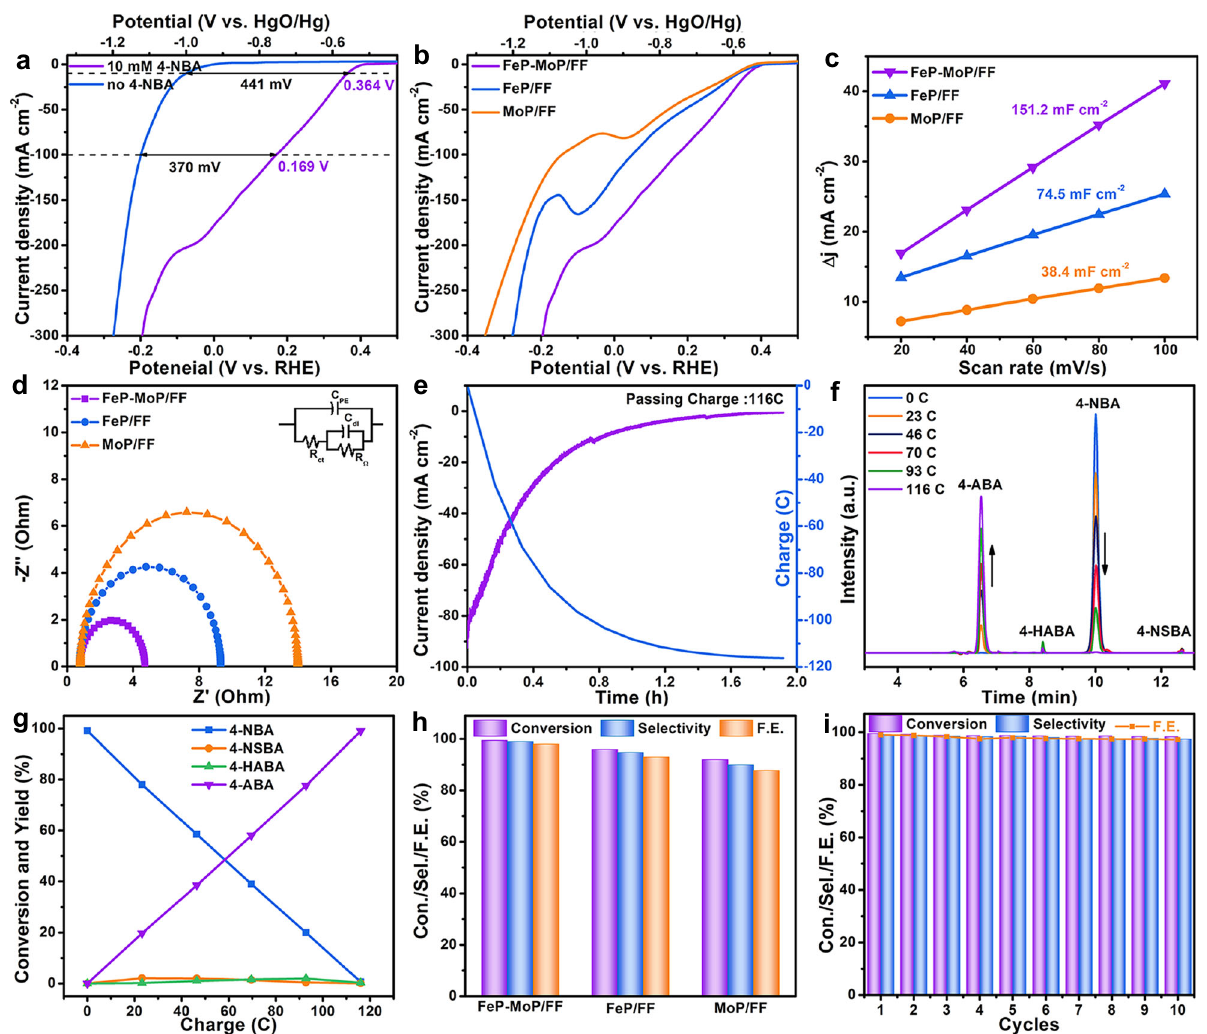
Fig. 3 4-NBA ERR performance. a LSV curves of FeP-MoP/FF in 1.0 M KOH without and with 10 mM 4-NBA at a scan rate of 5 mV s − 1 . b LSV curves, c Capacitive curves, and d Nyquist plots of FeP-MoP/FF, FeP/FF and MoP/FF. e Chronoamperometric response curve. f HPLC-trace acquired at various charges. g Conversion and yield of reduction products over passed charges. h The conversion, selectivity and FE of 4-NBA ERR for FeP-MoP/FF, FeP/FF and MoP/FF i Consecutive use of FeP-MoP/FF for ten successive